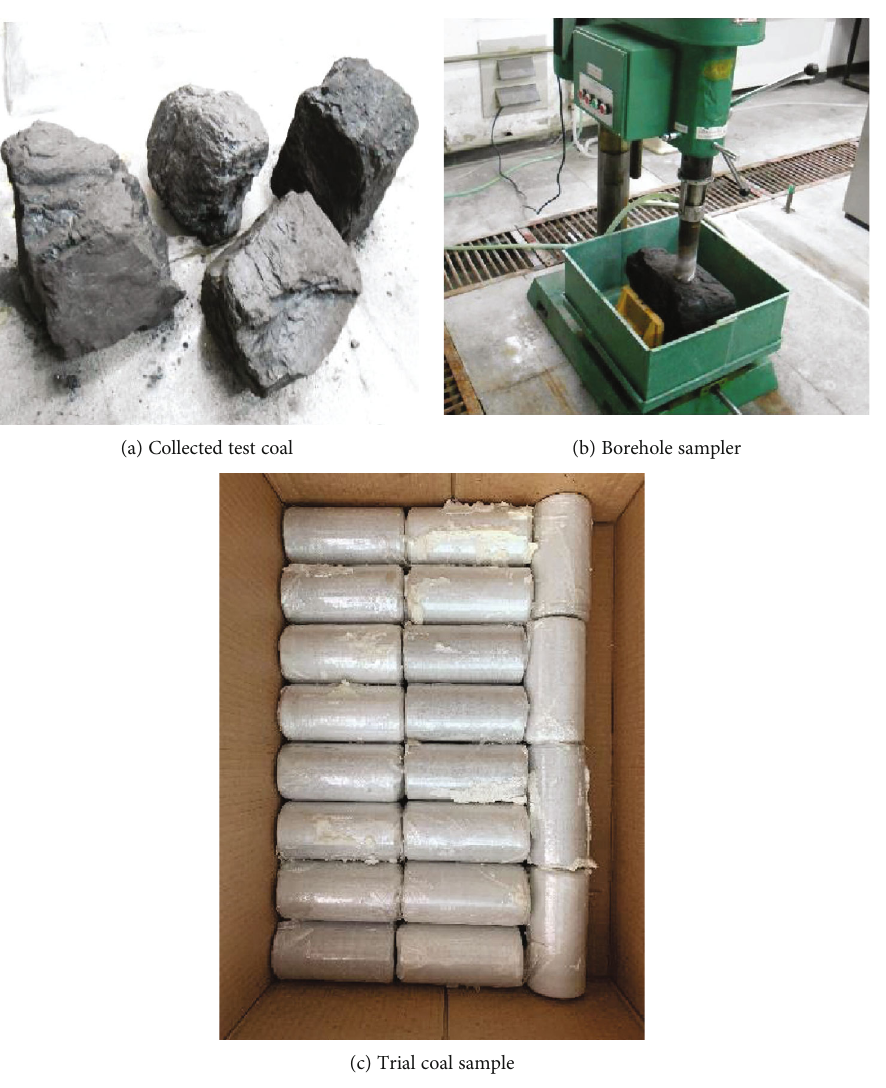
Figure 3: The collected coal, borehole sampler, and trial coal sample. Table 1: Physical parameters of coal